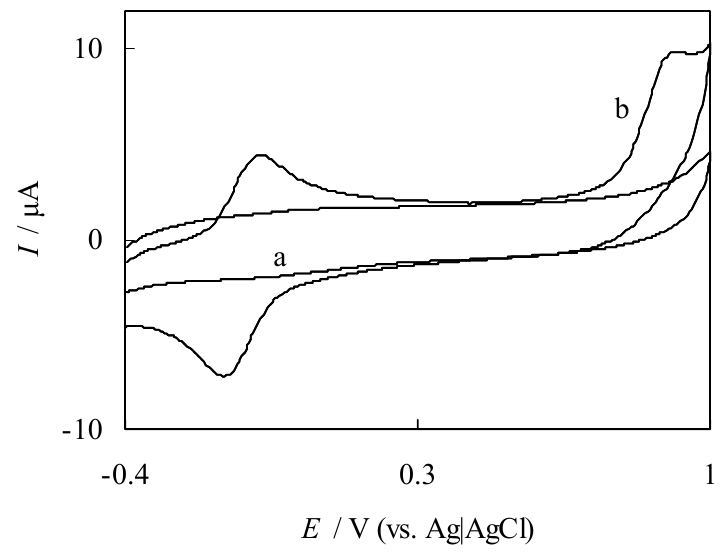
Figure 2. Cyclic voltammograms of DNA-PADDA film in a 0.05 M PBS (pH 7.4) (a) before and (b) after soaking 60 minutes. Scan rate, 200 mV s -1 Fig. 2 is the cyclic voltammogram obtained at a FePyDP and DNA-PADDA film-modified electrode in pH 7.4 PBS. The FePyDP film modified electrode showed a couple of characteristic Fe III /Fe II redox peaks of Fe(4-TMPyP) at –0.10 V and –0.17 V for a sweep rate of 200 mV s -1 with the peak-to-peak separation ( ∆ E p) of ca. 72 mV (Fig. 2b). In contrast, no CV peak was observed at the DNA-PADDA film-modified electrode under the same conditions in this potential range (Fig.